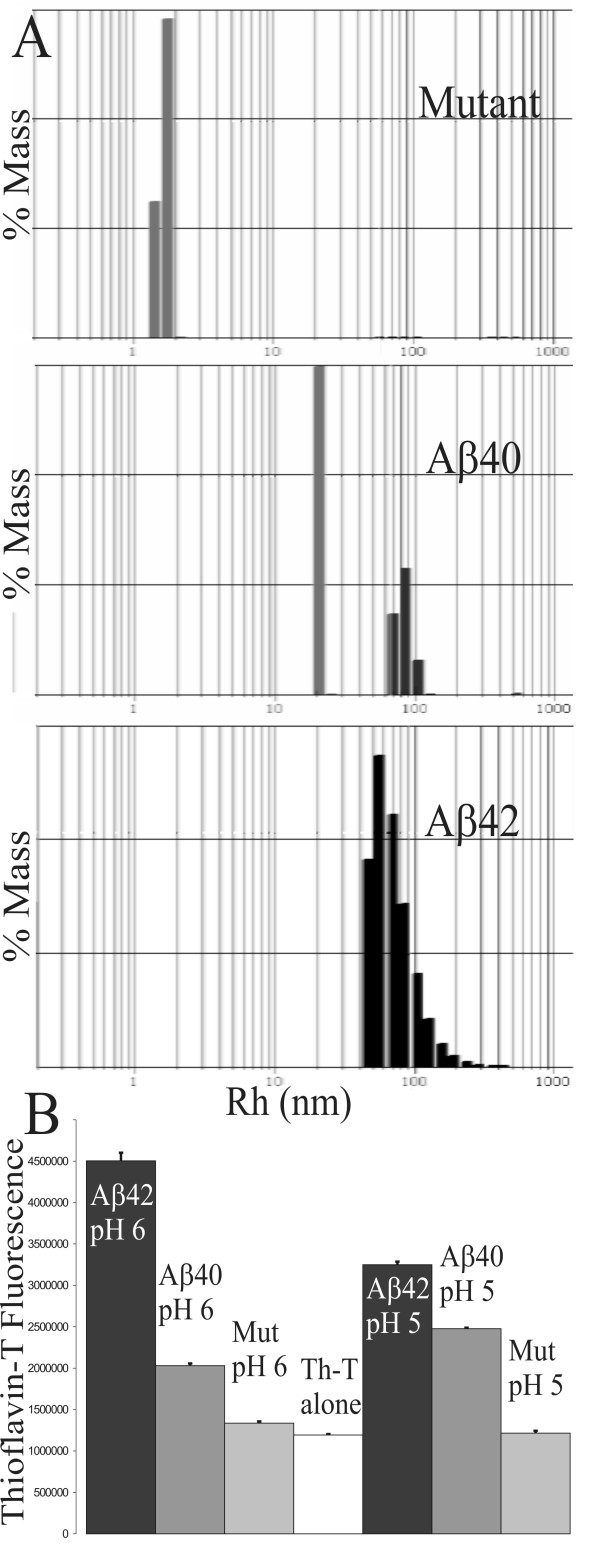
Comparison of aggregation propensities of different TMR-labelled Aβ. (A) Dynamic light scattering analysis indicated that very small particles (likely to be monomers) were present in the mutant peptide solution, two distributions of oligomers were present for Aβ40, and larger oligomers were present for Aβ42. (B) Aggregation marked by thioflavin-T fluorescence at pH 6 and pH 5 illustrated weak fluorescence for the mutant peptide (Mut), moderate aggregation for Aβ40, and the highest aggregation for Aβ42. The thioflavin-T alone sample represents the total emission peak area for a control sample not containing any Aβ. The data from these techniques indicates that the rank order of aggregation propensity is Aβ42 > Aβ40 > mutant.